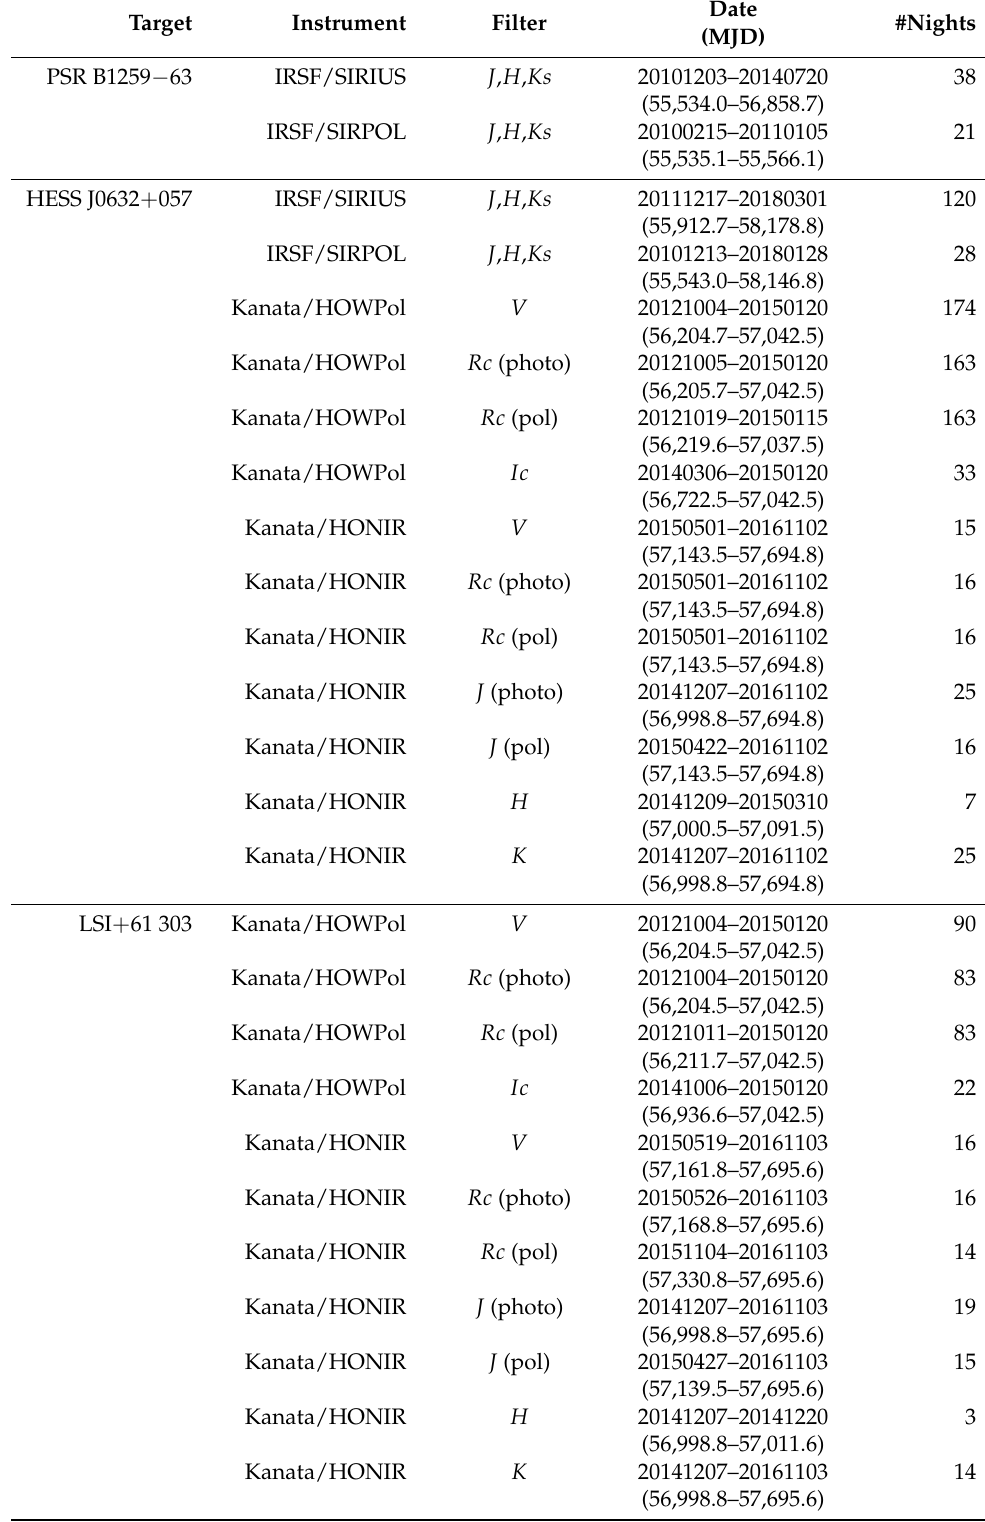
Table 1. Summary of the observations. Column 1 is the target name. Columns 2 and 3 list the used instrument and filters, respectively. Columns 4 and 5 list the observational period (in terms of dates and MJD) and the number of the nights during